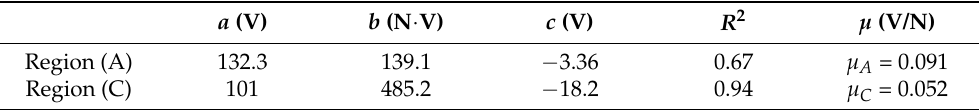
Table 2. Parameters resulting from the fit. Parameters a through c were obtained from a least-squares fit to (8) with coefficient of correlation R 2 . The mean sensitivity ( µ ) for each region ( µ A , µ C ) was measured at U = 3 V. a (V) b (N · V) c (V) R 2 µ (V/N) Region (A) 132.3 139.1 − 3.36 0.67 µ A = 0.091 Region (C) 101 485.2 − 18.2 0.94 µ C =